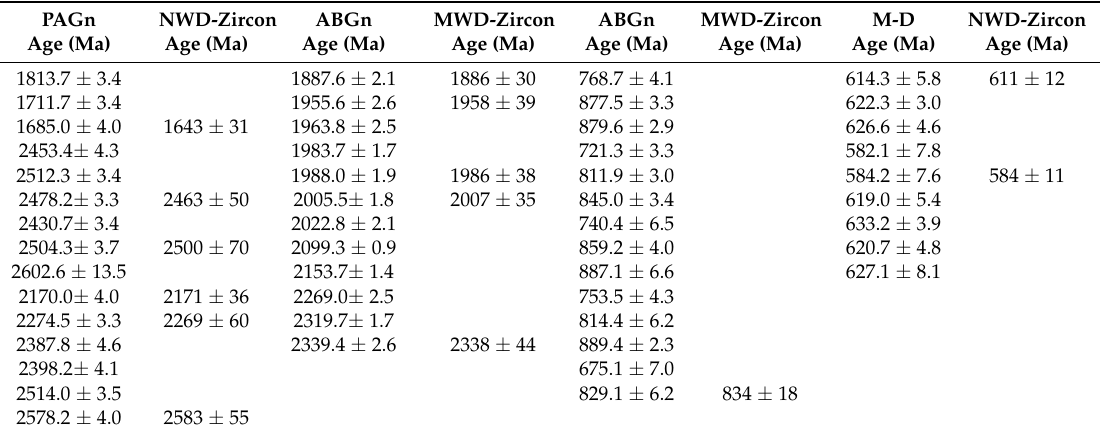
PAGn: Pyroxene-amphibole gneiss; MWD-Zircon: Western Meiganga detrital zircon, ABGn: Amphibole-biotite gneiss; M-D: